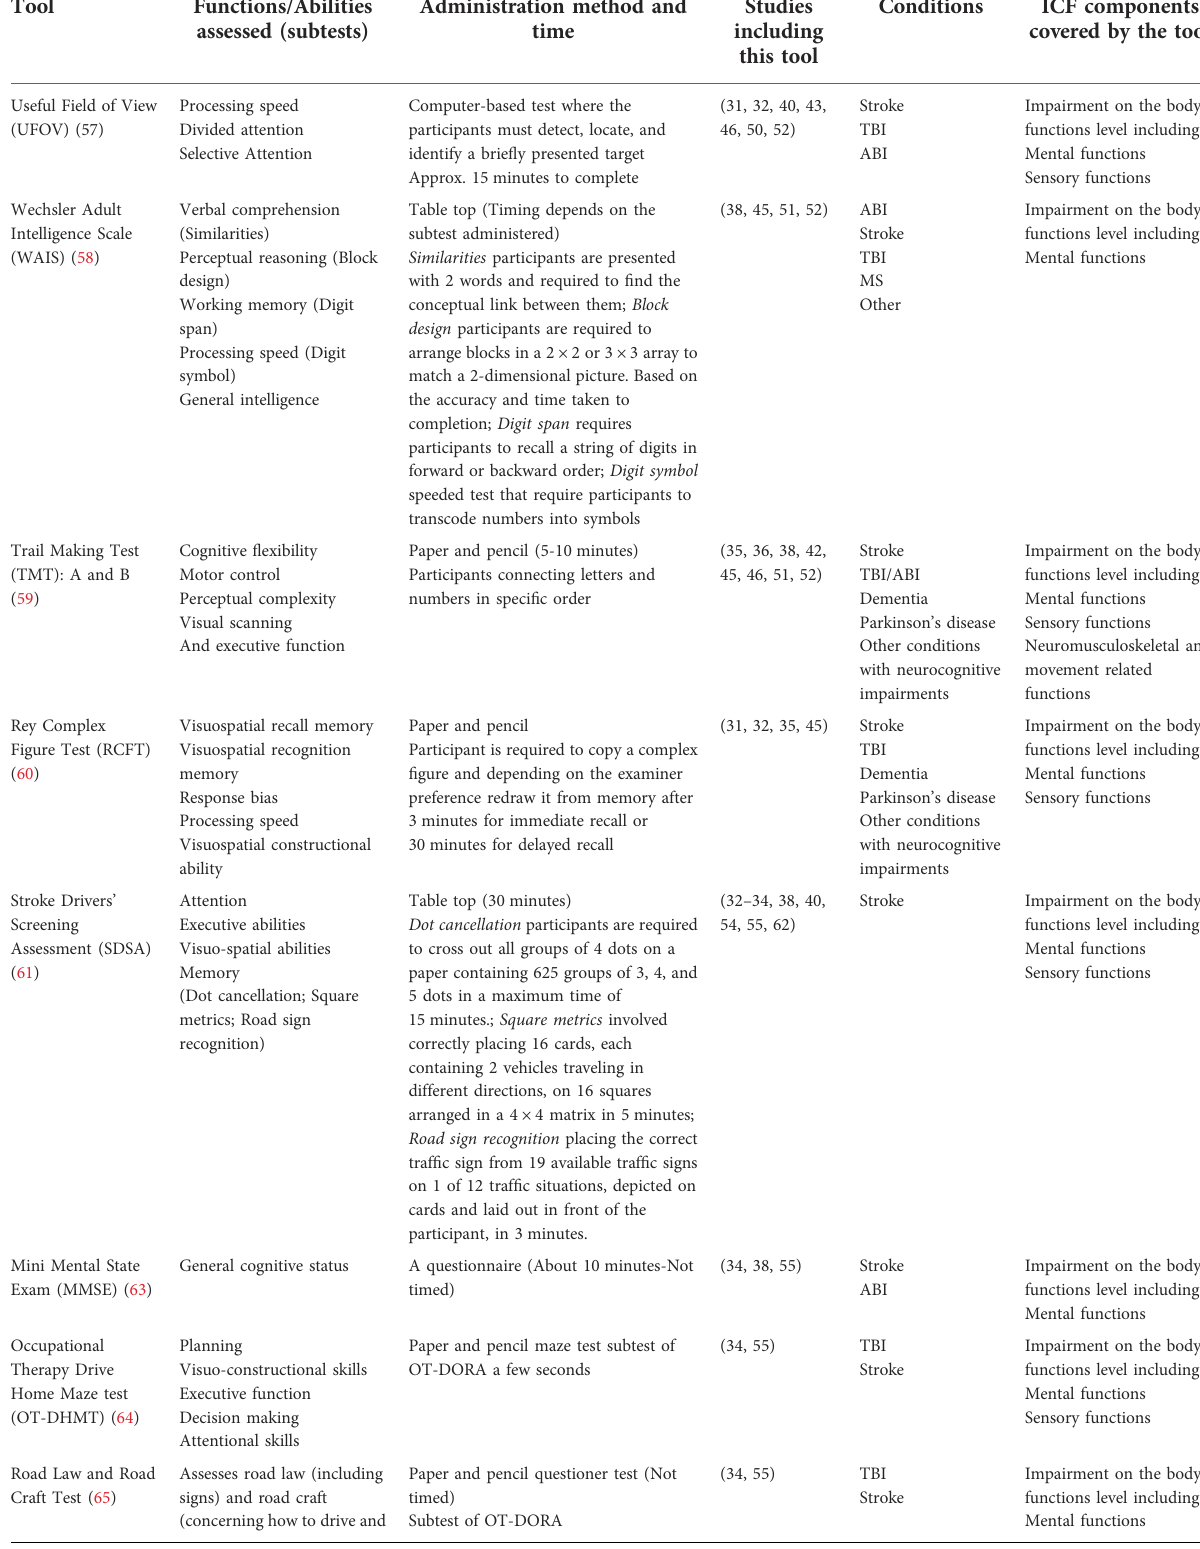
TABLE 3 Clinical assessment tools used in assessing competence to drive following ABI.